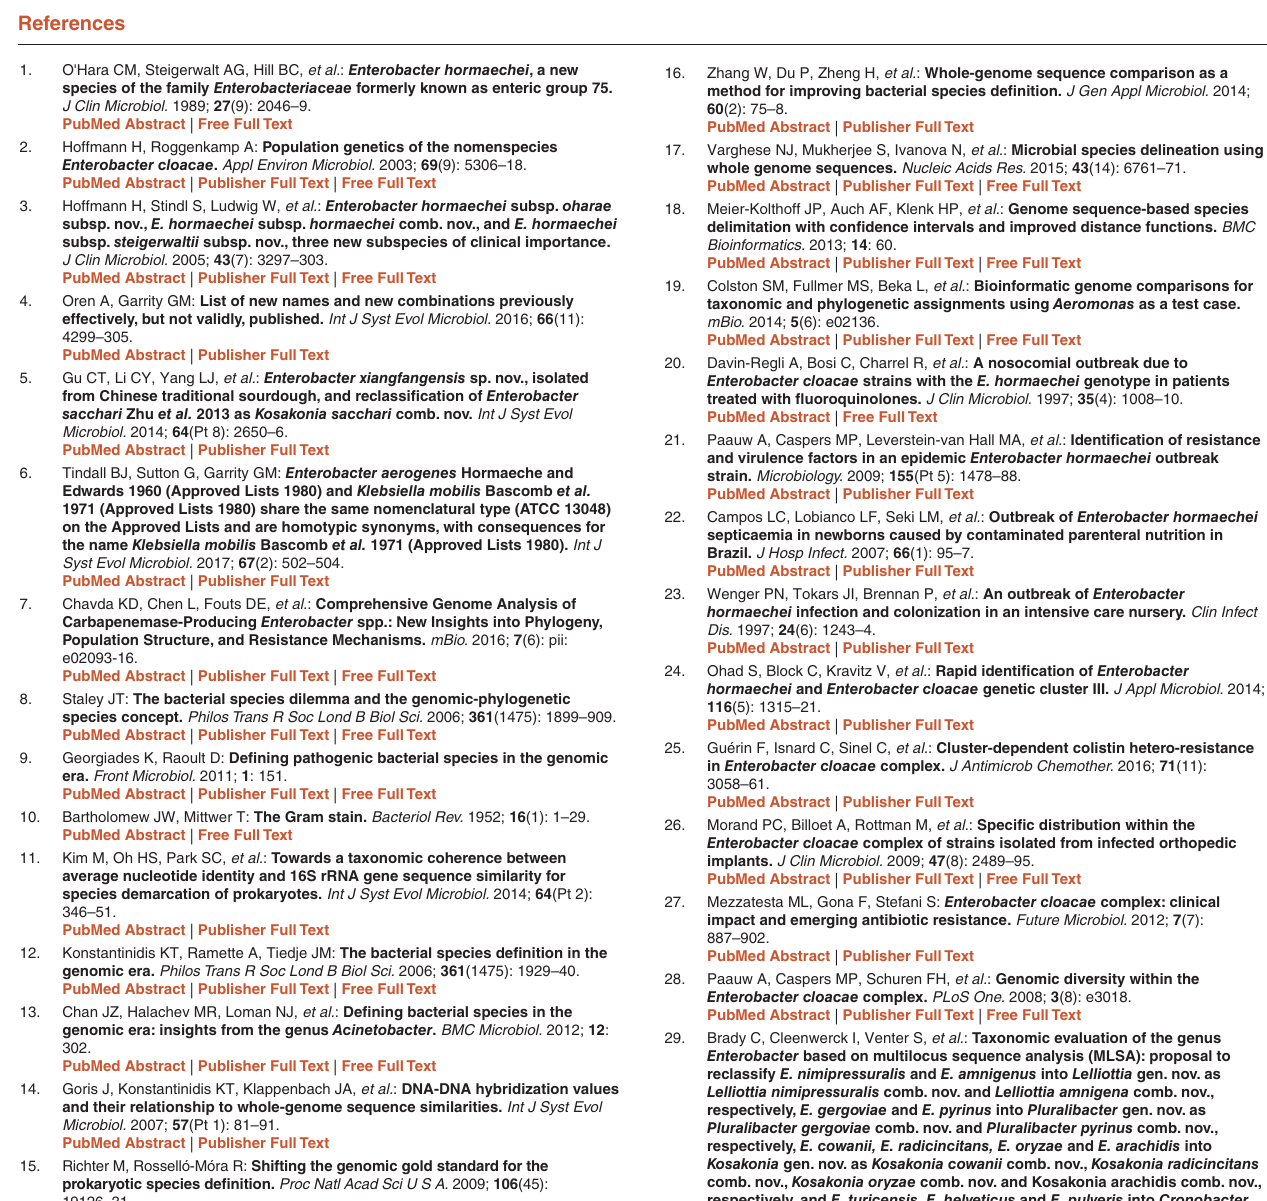
Supplemental Figure 3. Graphs of PanOCT ANI, MASH, and GGCD genome distance measures. Click here to access the data. Supplemental File 1. Newick formatted tree generated from Supplemental Table 5 and used to generate Figure 1. Click here to access the